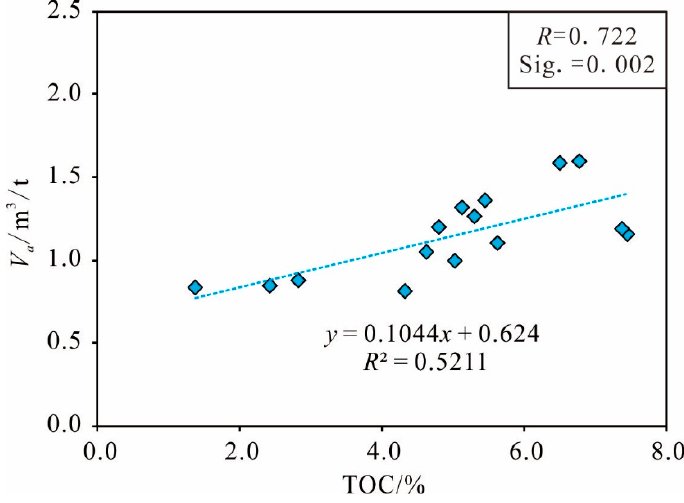
Figure 7. Significant positive relationship between V a and TOC.